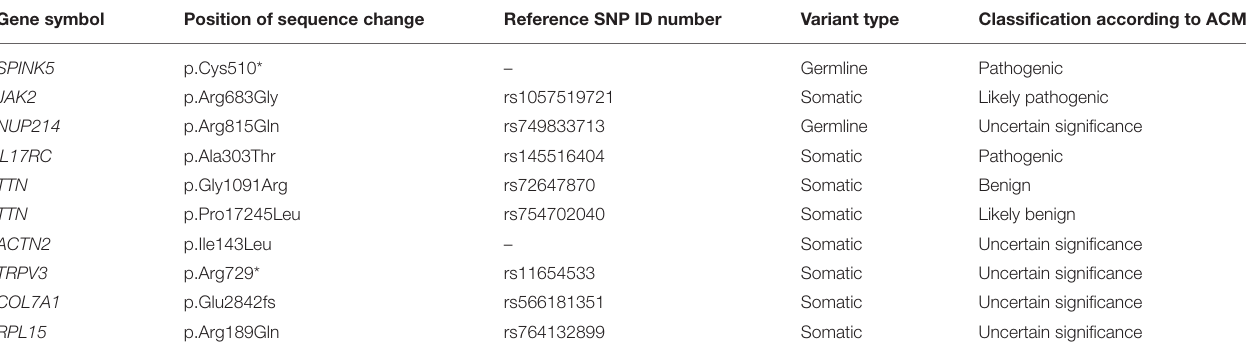
TABLE 1 | Selected somatic and germline genetic variants detected in the